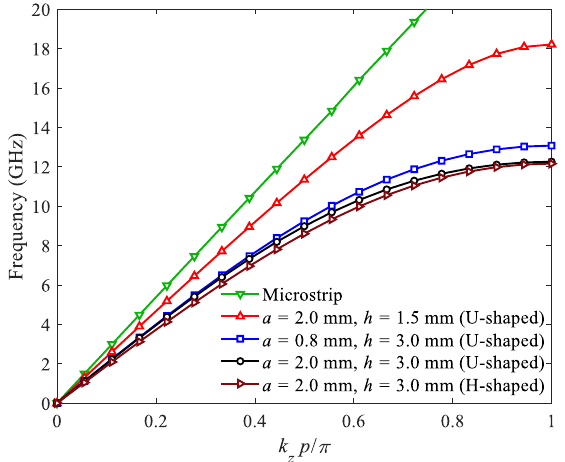
Figure 2. Dispersion curves of the corrugated SWTLs.